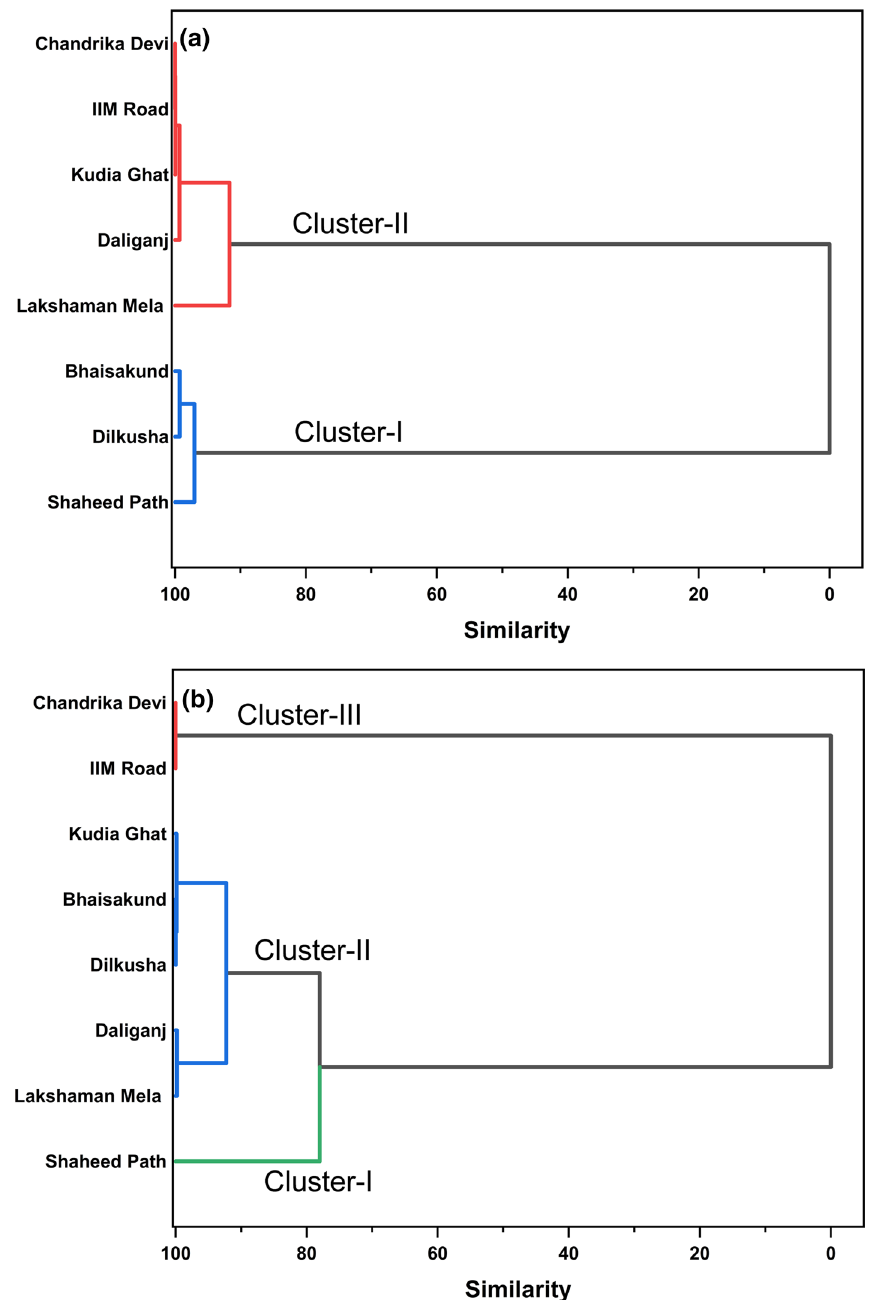
Fig. 3 Dendrograms for Q-mode hierarchical cluster analysis (Q-HCA) for the data- set from a pre-riverfront devel- opment and b post-riverfront